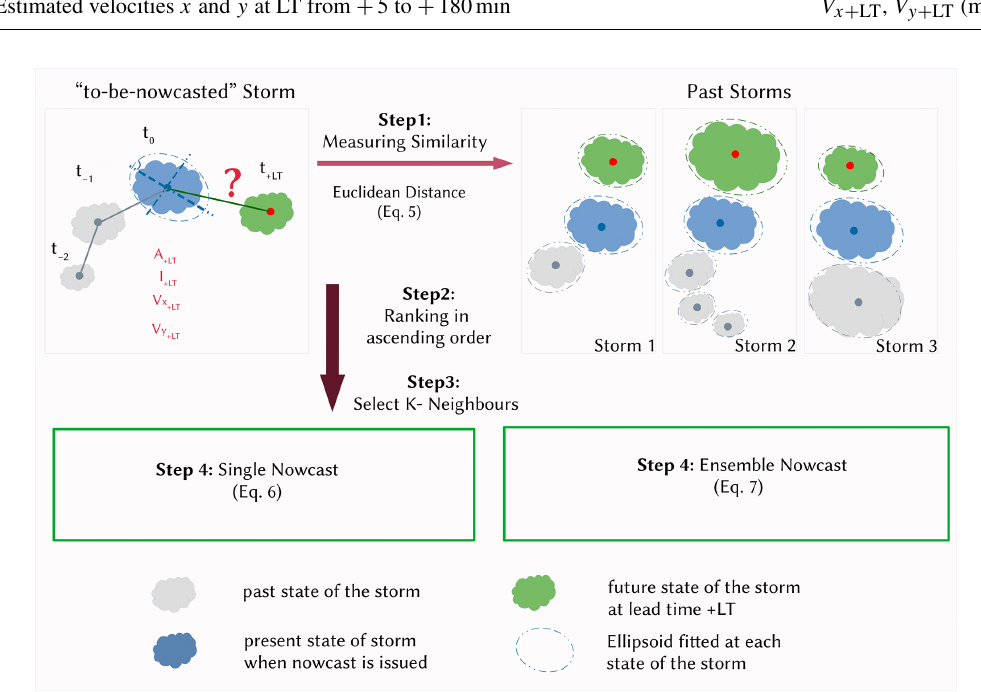
Figure 6. The main steps involved in the k -NN-based nowcast with the estimation of similar storms (Steps 1 to 3) and assigning the future responses of past storms as the new response of the “to-be-nowcasted” storm either in a deterministic nowcast (Step 4 – left) or in a probabilistic nowcast (Step 4 –